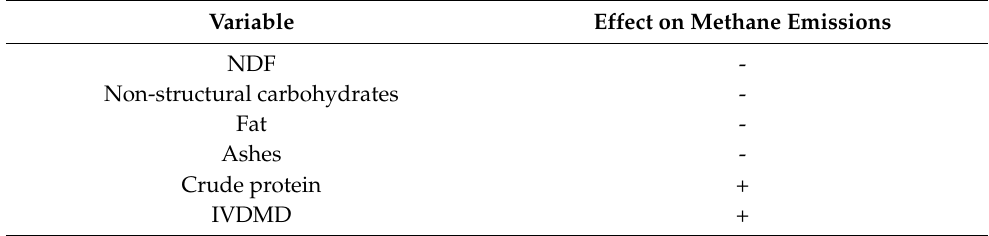
Table 5. Influence of the variables entered in the RUMINANT model on methane emissions. Variable Effect on Methane Emissions NDF - Non-structural carbohydrates - Fat